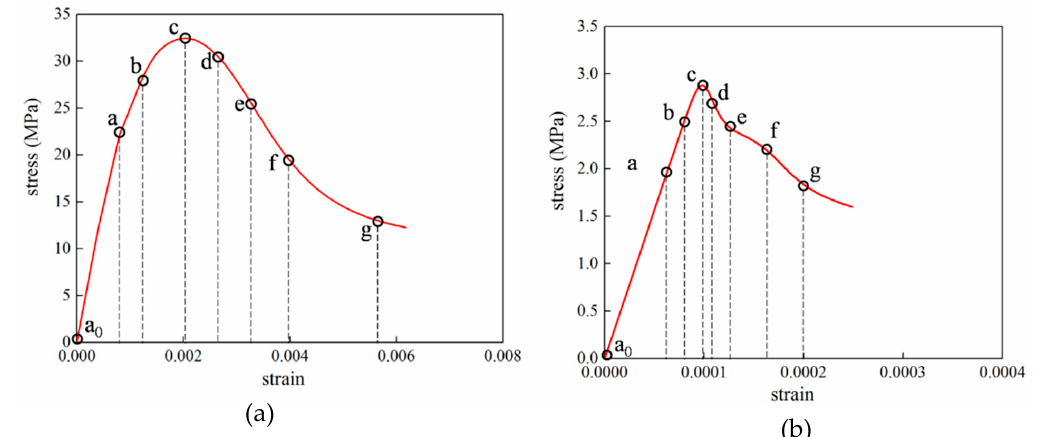
Figure 28. Points marked in stress–strain curves: ( a ) Compressive curve, ( b ) tensile curve.